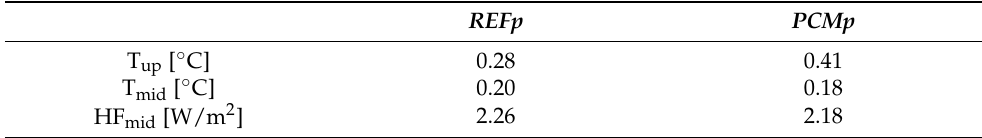
Figure 7. Verification of the mesh independence of the experimental set up model. Table 6. RMSE calculated for both